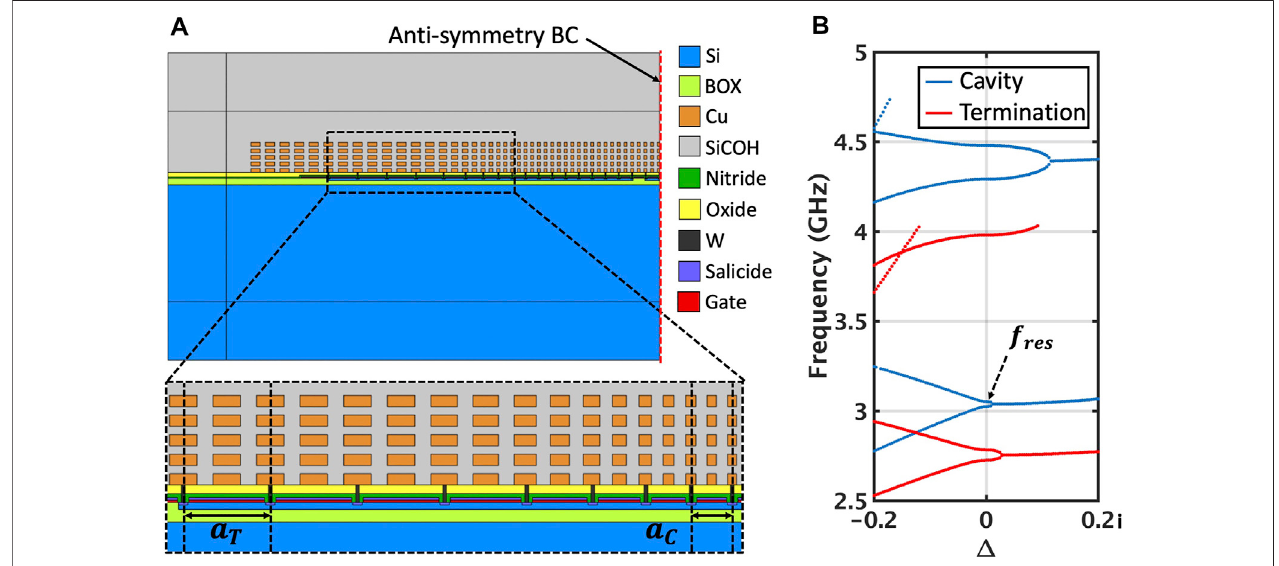
FIGURE 5 | (A) Schematic showing half of the IBM12RF RBT 2D-FEM model with an Anti-symmetric Boundary Condition (BC). The adiabatic transition from the cavity lattice constant a C to the termination lattice constant a T can also be seen. (B) Complex bandstructure for the waveguide and termination regions with the x-axis representing wavenumber detuning from the point X in the IBZ. The cavity waveguide mode has a resonance at f res .